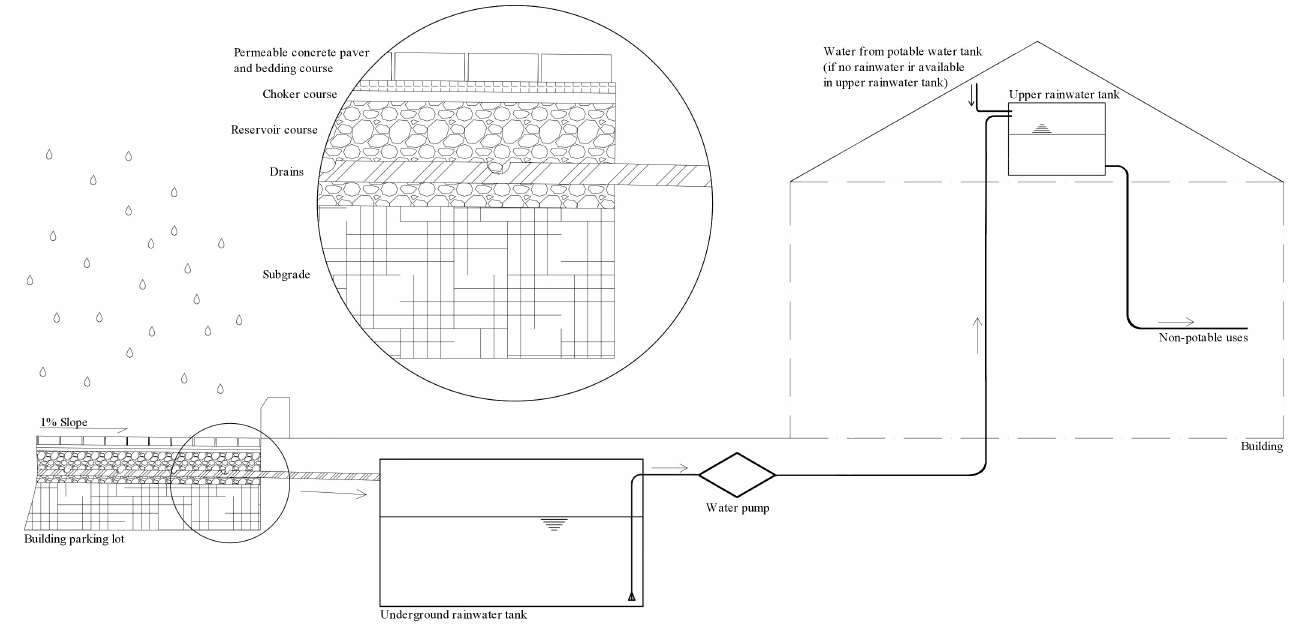
Figure 2. Permeable pavements rainwater harvesting system. Source: Adapted